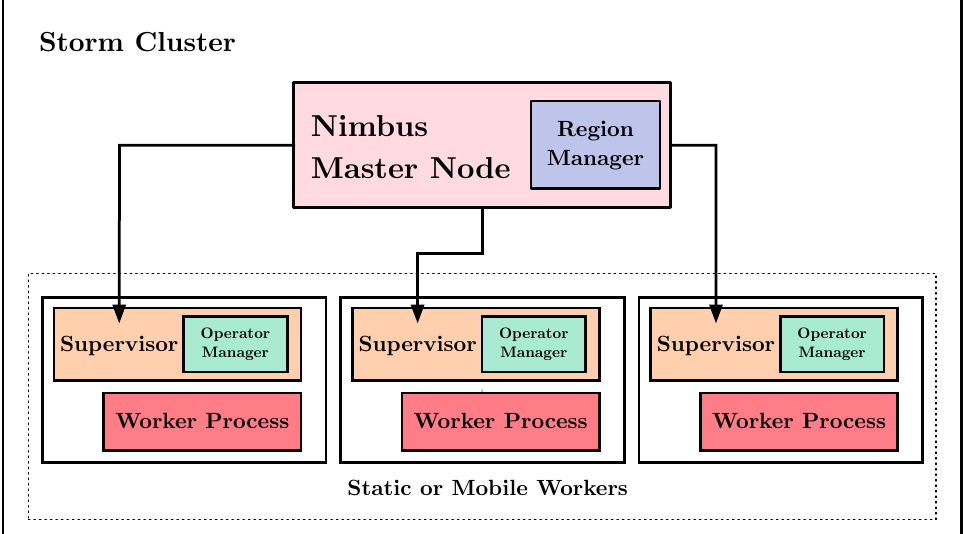
Figure 2. Integration of the model’s components with